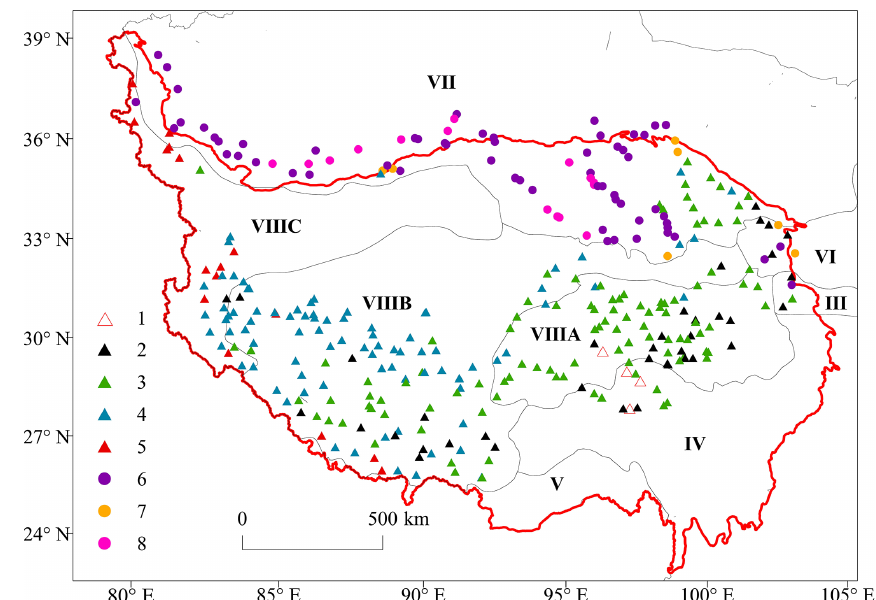
Figure 2. Site distribution of the TiP-Leaf dataset. Vegetation regions were extracted from the vegetation regionalisation of China (ECVMC, 2007b): III, Warm Temperate Deciduous Broad-leaf Forest Region; IV, Subtropical Broad-leaf Evergreen Forest Region; V, Tropical Mon- soon Rain Forest and Rain Forest Region; VI, Temperate Steppe Region; VII, Temperate Desert Region; VIII, TP Alpine Vegetation Region. VIIIA, East TP Alpine Scrub and Alpine Meadow Subregion; VIIIB, Middle TP Alpine Steppe Subregion; VIIIC, Northwest TP Alpine Desert Subregion. Vegetation types were classified on the basis of field records. Numbers indicate the vegetation types recorded in the field. 1, coniferous forest; 2, alpine shrubland; 3, alpine meadow; 4, alpine steppe; 5, alpine desert; 6, temperate desert; 7, temperate steppe; 8, temperate meadow. The background map is from the Chinese National Bureau of Surveying and